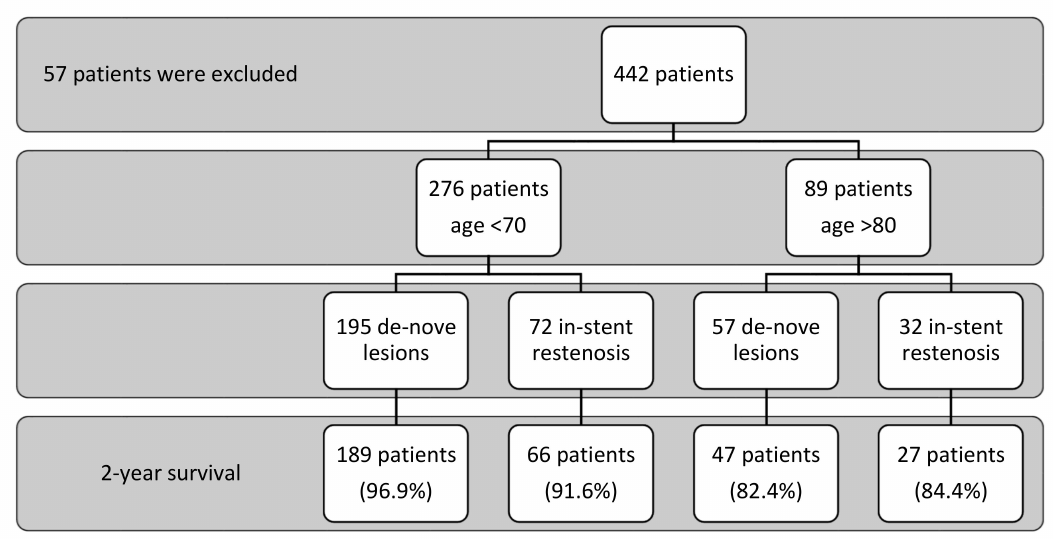
Figure 1. Patient